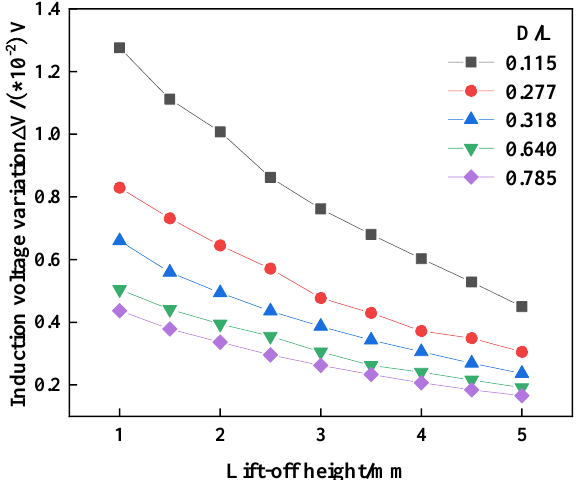
Figure 8. The shape coefficient of excitation coil affects the curve.